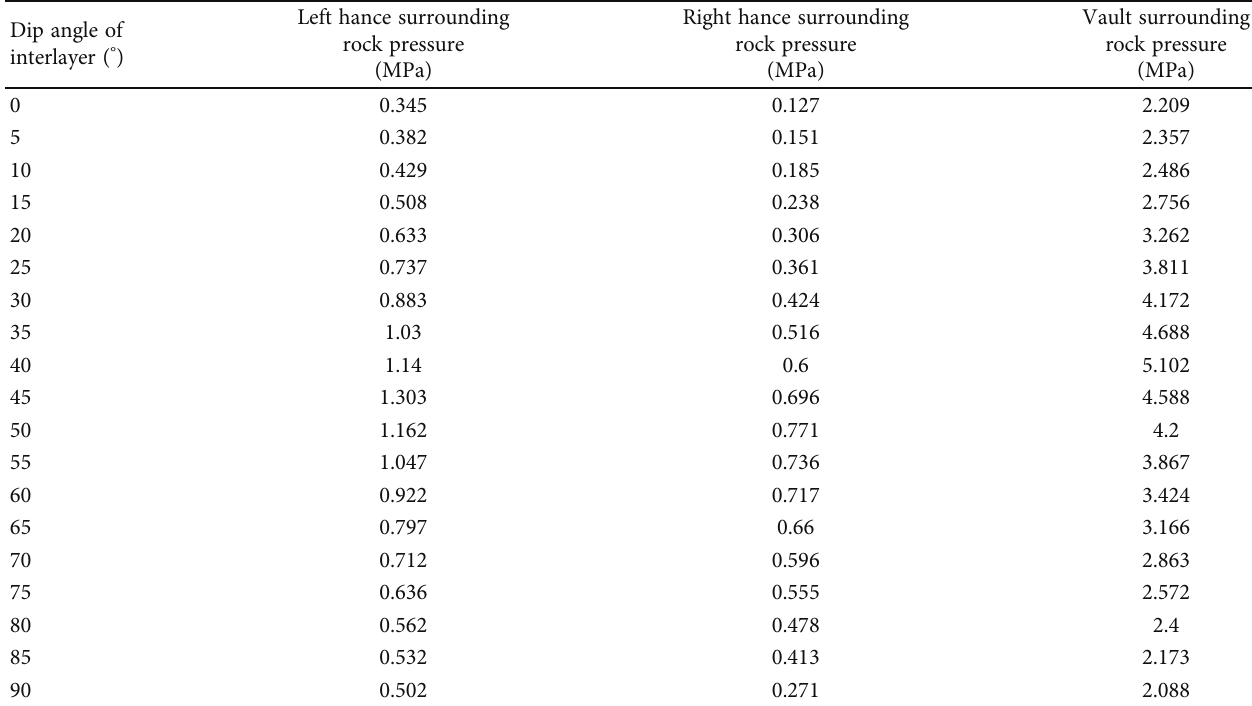
Table 2: Weak interlayer with di ff erent inclination angles corresponding to the surrounding rock pressure value of left hance, right hance, and the